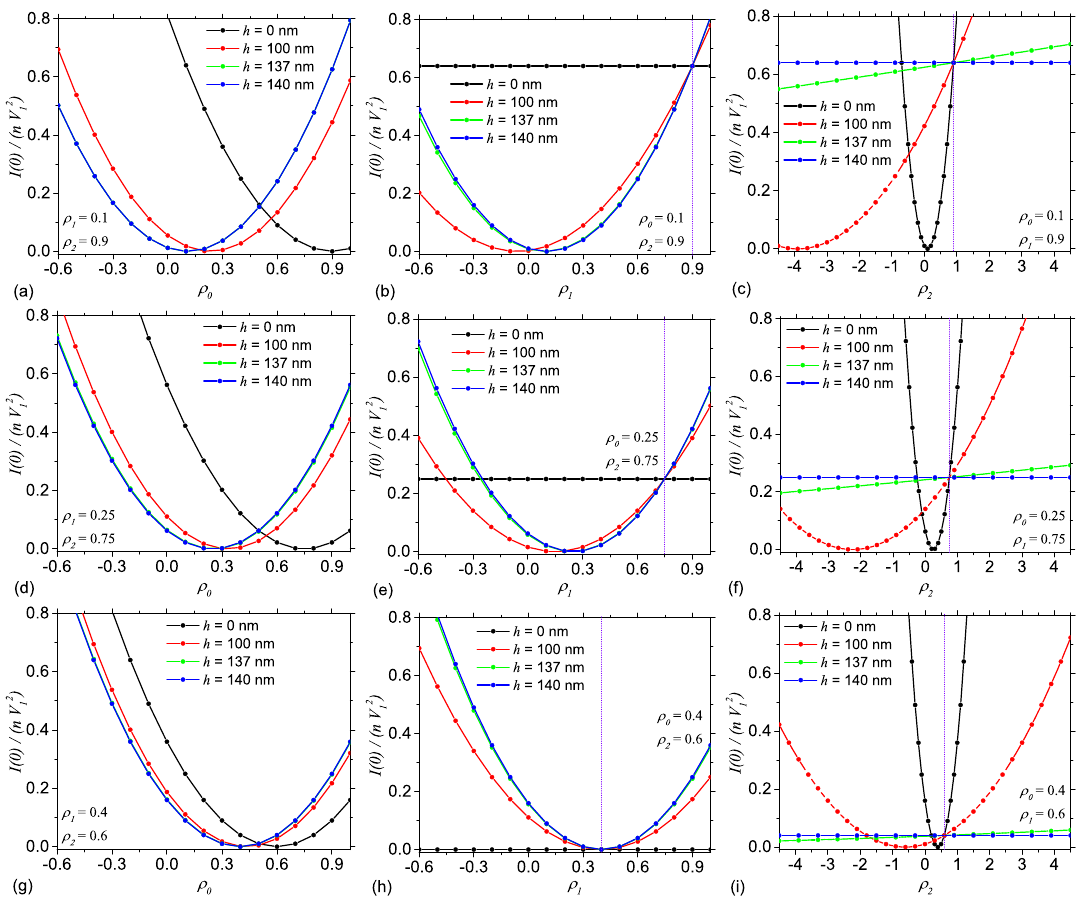
Figure 8. (Color online) Scattering intensities from AnJPs at q = 0, as a function of SLD of different regions, for fixed values of height h : ( a , d , g ) variation with solvent density ρ 0 ; ( b , e , h ) variation with solvent density ρ 1 ; and ( c , f , i ) variation with solvent density ρ 2